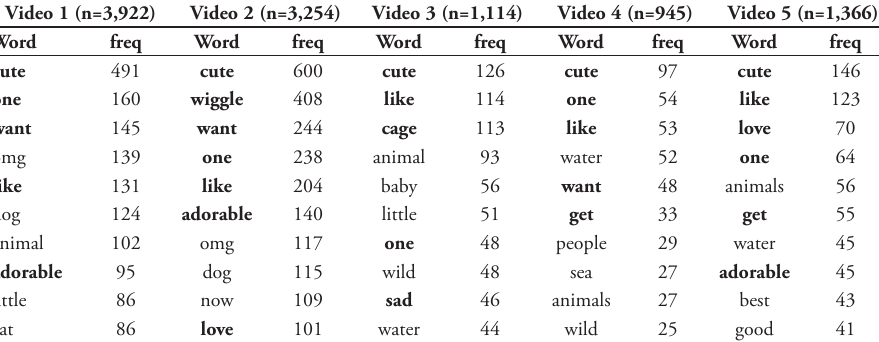
Table 2. Most frequently cited words in potential influencer English-language pet otter videos. n is the number of comment lines analysed; freq is the number of times the word occurred in the entire document and was not necessarily the same as the number of comments that the word occurred in. Specific words mentioned in the text are